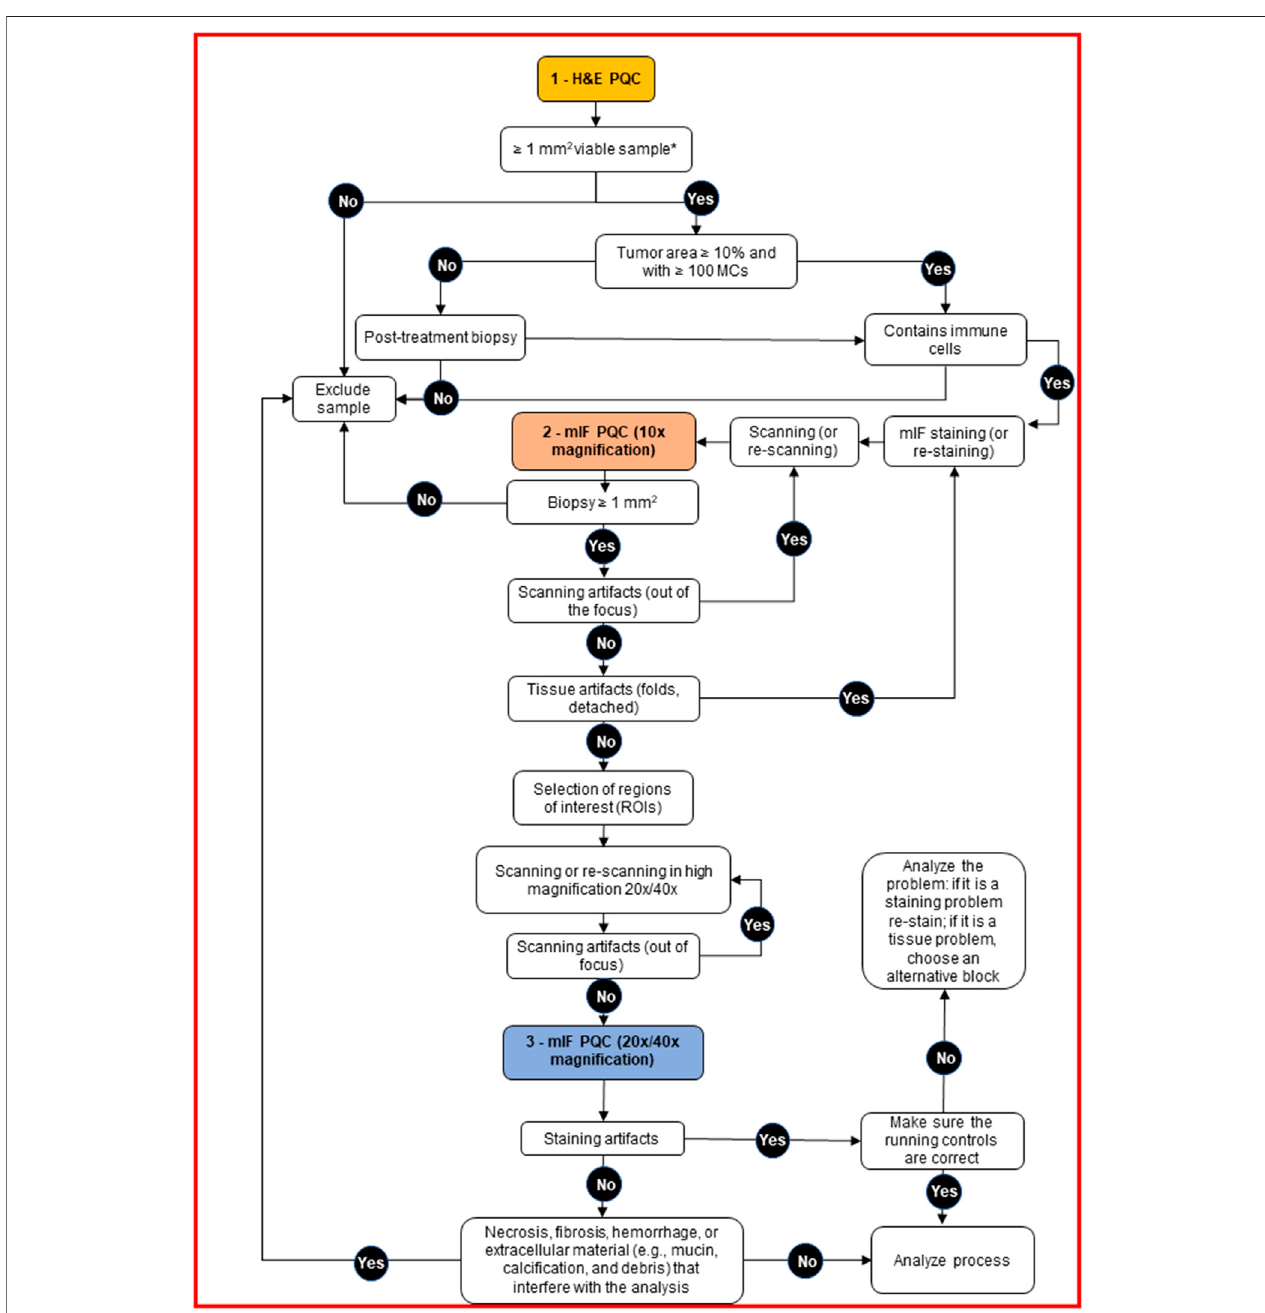
FIGURE 2 | Decision tree for pathology quality control (PQC) of core needle biopsy sample assessment for multiplex immuno fl uorescence and digital image analysis. The tree shows the detailed protocol with corresponding decisions for the pathologist tomake during the three PQC steps. H&E, hematoxylinand eosin; MCs, malignant cells; mIF, multiplex immuno fl